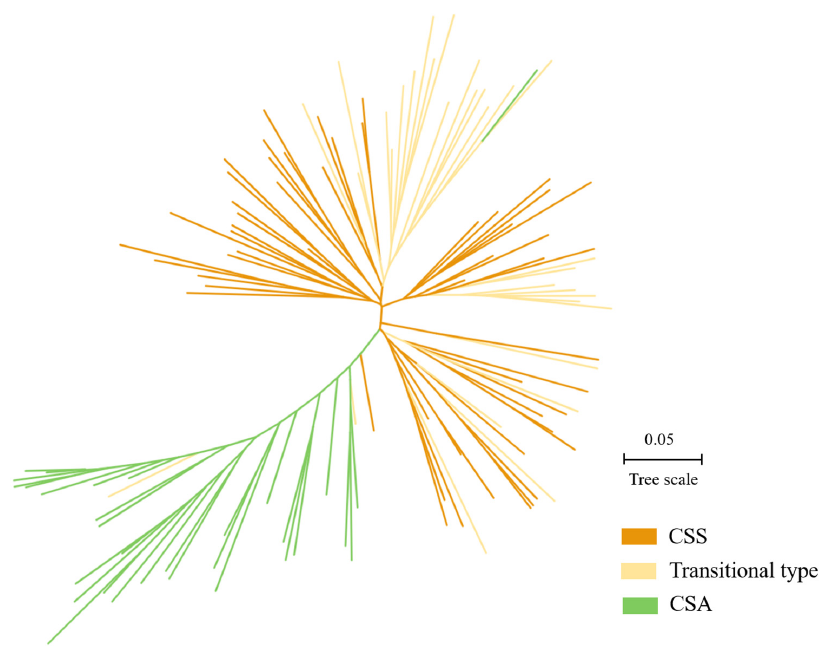
Figure 5. Phylogenetic analysis of the 117 tea cultivars based on the 45 SNP markers.